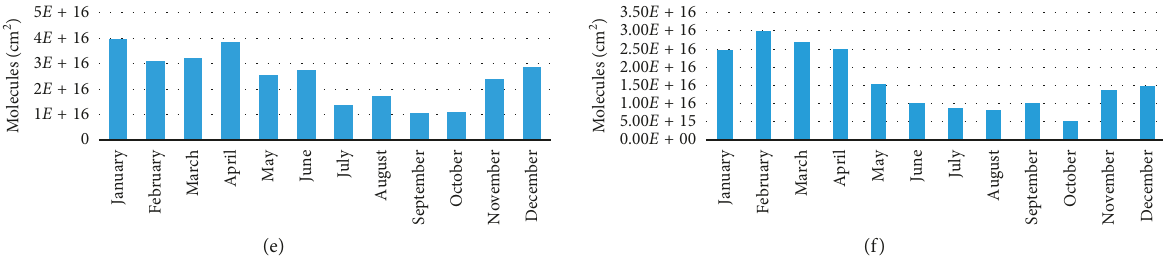
Figure 5: Seasonal variations of ammonia columns (molecules/cm 2 ) over different regions of the study area. The trend over IGP-4 and IGP- 5 shows discrepancy from the observed normal for the other regions. (a) IGP-1A. (b) IGP-1B. (c) IGP-2. (d) IGP-3. (e) IGP-4. (f)